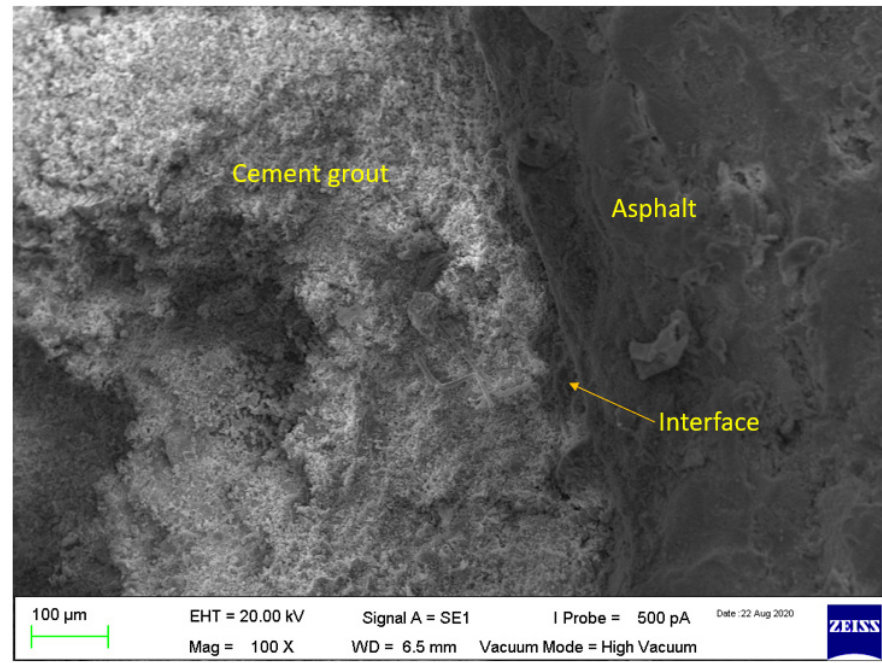
Figure 10. SEM micrograph of semi-flexible with Irradiated PET-based grout.